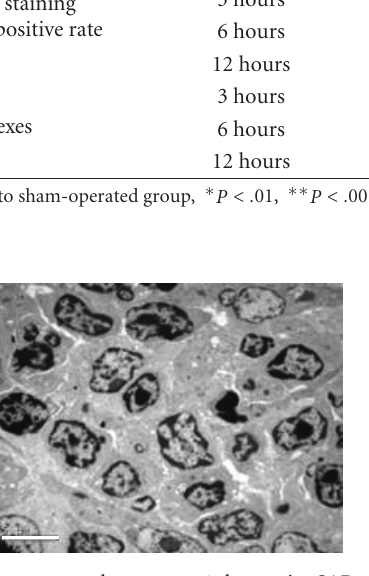
Figure 3: Sham-operated group—12 hours in SAP experiment thymus (normal), Electron microscope × 2550.